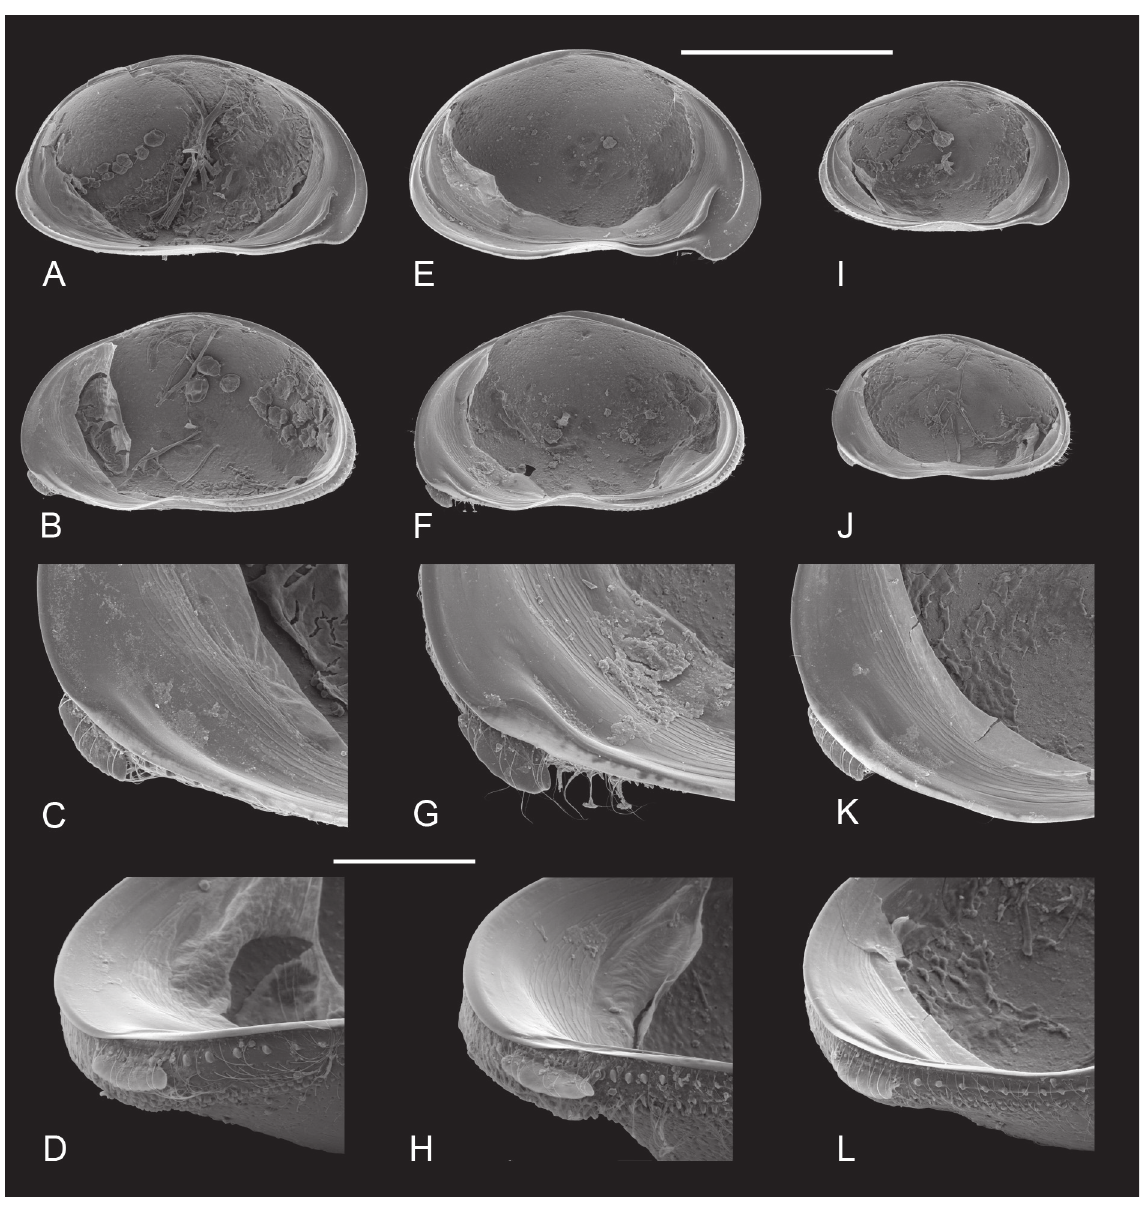
Fig. 24. Bennelongia spp. (no museum nrs), females. — A-D . Bennelongia sp. X1. crane Pan (Os.255). A . lVi. B . rVi. C . rVi, detail anterior. D . rVi, detail anterior, tilted. — E-H . ? Bennelongia scanloni sp. nov., lake cronin (Os.544). E . lVi. F . rVi. G . rVi, detail anterior. H . rVi, detail anterior, tilted. — I-L . Bennelongia dedeckkeri , lake Gregory (Os.260). I . lVi. J . rVi. K . rVi, detail anterior. L . rVi, detail anterior, tilted. scales: a-B, e-F, I-J = 1 mm; c-D, G-H, K-l = 200